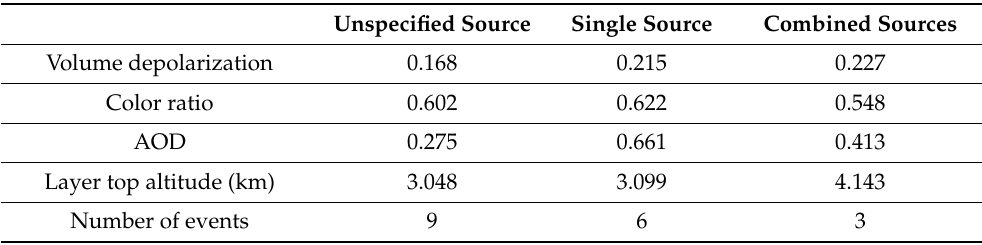
Table 3. Characteristics of dust layers observed within 220 km of Kuwait City analyzed from the CALIPSO images.